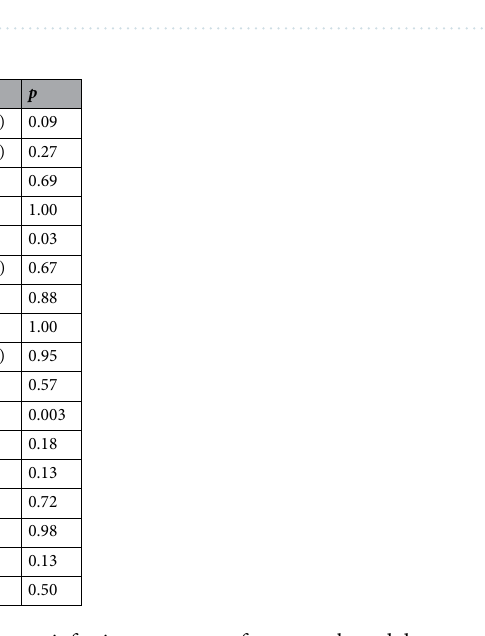
Table 3. Comparison of COVID-19 patients according to infection symptoms: fever, cough, and dyspnea.